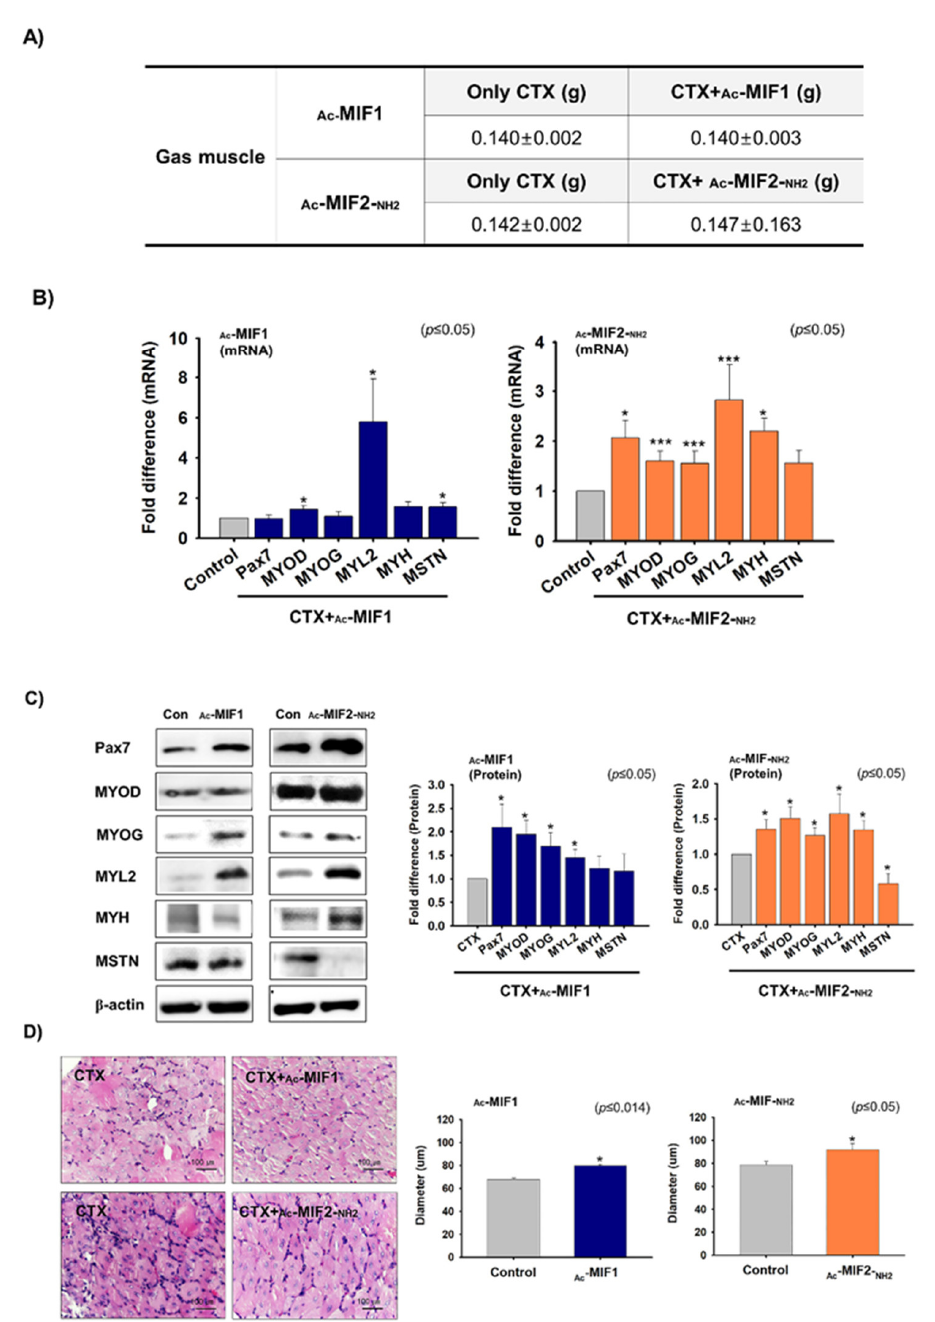
Figure 6. Effects of Ac -MIF 1 & Ac -MIF2- NH2 peptides on muscle regeneration. ( A ) Ac -MIF1 or Ac -MIF2- NH2 peptides were injected into mouse left gastrocnemius muscles. After 1 day, CTX was injected and maintained for 7 days (right leg muscles: CTX injection only, left leg muscles: CTX + Ac -MIF1 or Ac -MIF2- NH2 ). Body and muscle weights of CTX-injected and CTX + MIF-peptide-injected muscles were measured. ( B , C ) Pax7, MYOD, MYOG, MYL2, MYH, and MSTN mRNA and protein expression in CTX-injected and CTX + MIF-peptide-injected muscles as determined by real-time RT-PCR and Western blot, respectively. ( D ) H&E staining and myofiber diameters in CTX-injected and CTX + Ac -MIF1-, CTX + Ac -MIF2- NH2 -, and CTX + Ac -MIF1 + Ac -MIF2- NH2 -injected muscles. CTX-only-injected muscles were used as controls. Means ± SD ( n ≤ 3) (* p ≤ 0.05, ** p ≤ 0.001, *** p ≤ 0.0001). The effects of MIFs on preadipocyte proliferation and differentiation were investi- gated in 3T3-L1 cells. First, 3T3-L1 cells were cultured in a 3T3-L1 growth medium sup-